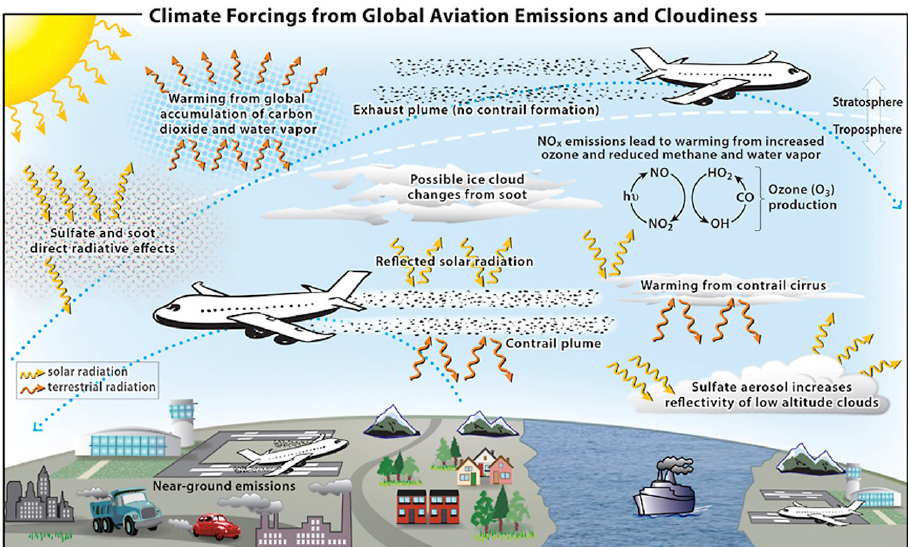
Figure 12. Schematic overview of climate forcing mechanisms induced by aircraft emissions. Reprinted with permission from Lee et al. [1]. Copyright 2022,